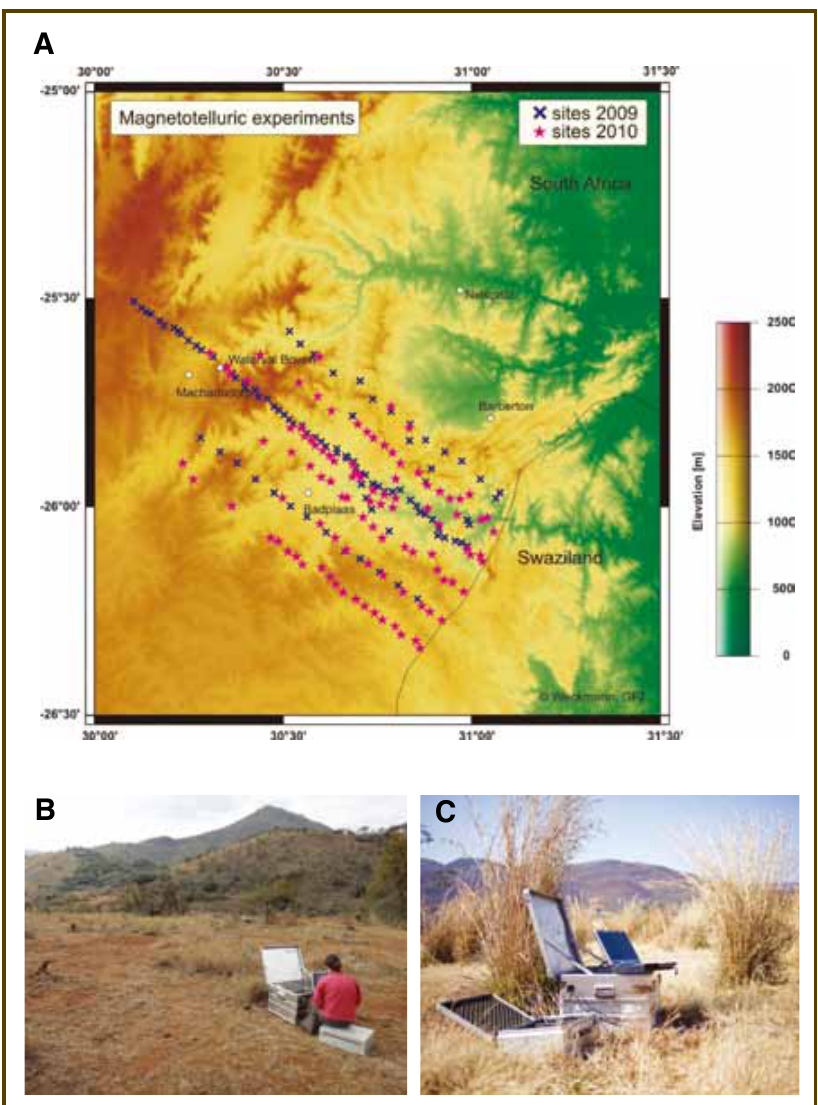
Figure 3A. [A] Layout of the high-resolution magnetotelluric (MT) survey across the Inyoka Shear Zone that runs approximately between Barberton and Badplaas. [B, C] Typical field setup of MT stations. Care was needed to ensure the equipment and cables were not damaged by wild animals, including rhinos and